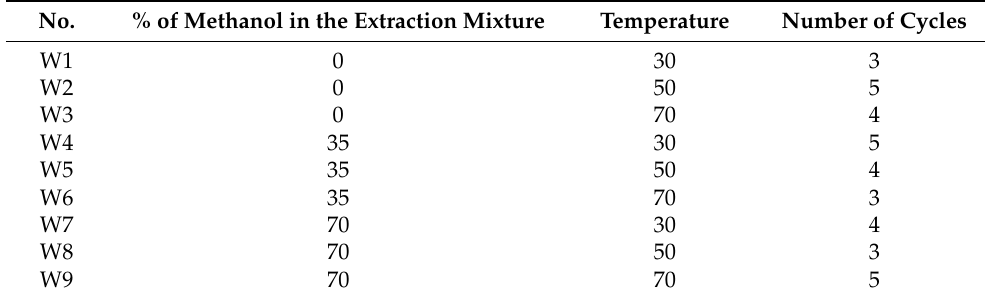
Table 1. Factorial Extraction Process Experiment